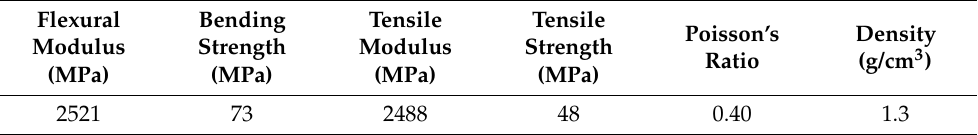
Table 3. The parameters of the photosensitive resin.